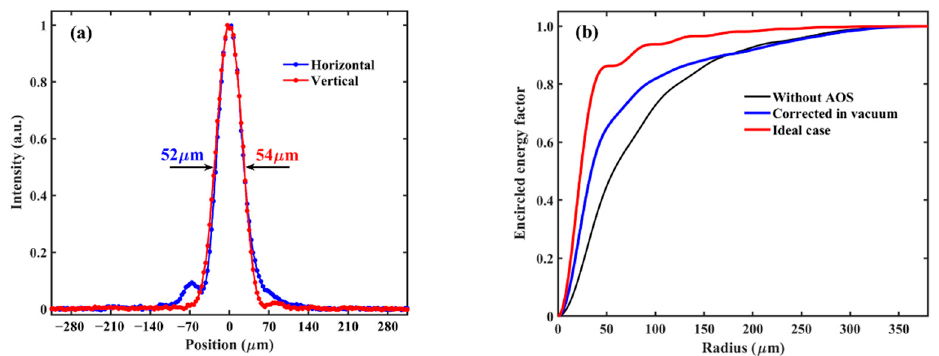
Figure 5. The ( a ) cross-sectional profiles of the focal spot after wavefront correction in vacuum, and the ( b ) encircled energy factor with and without wavefront correction in vacuum.